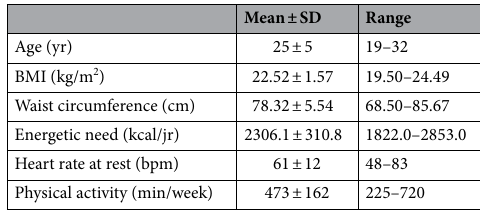
Table 1. Initial characteristics of subjects (n =